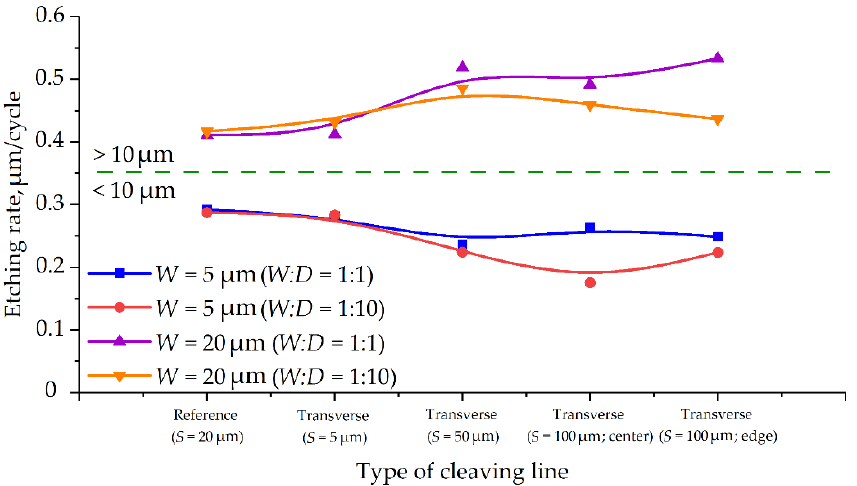
Figure 11. Etching rate change depending on cleaving auxiliary lines type and target lines width.